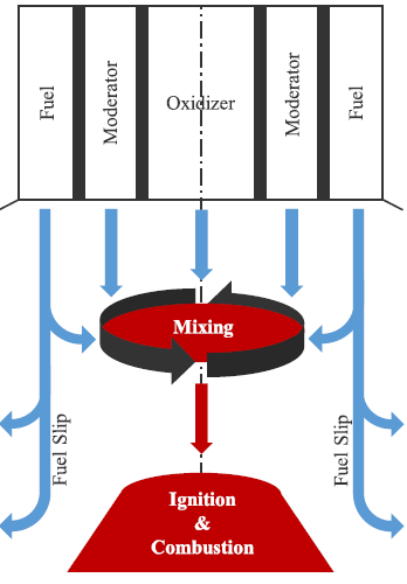
Figure 1. Reactant mixing diagram for the concentric oxygen burner nozzle design used in the POX reactor [60].